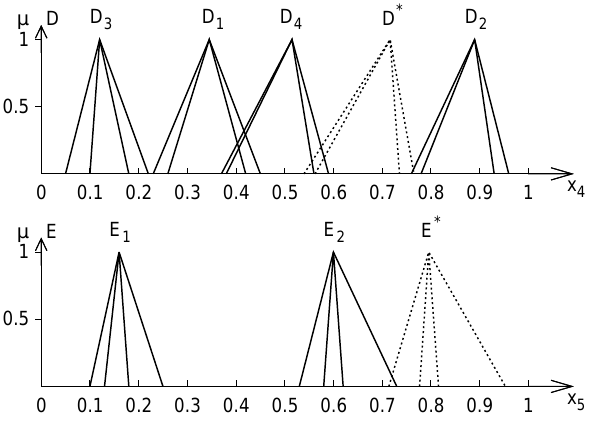
Figure 10. Interpolated results from interval type-2 interpolation [23].